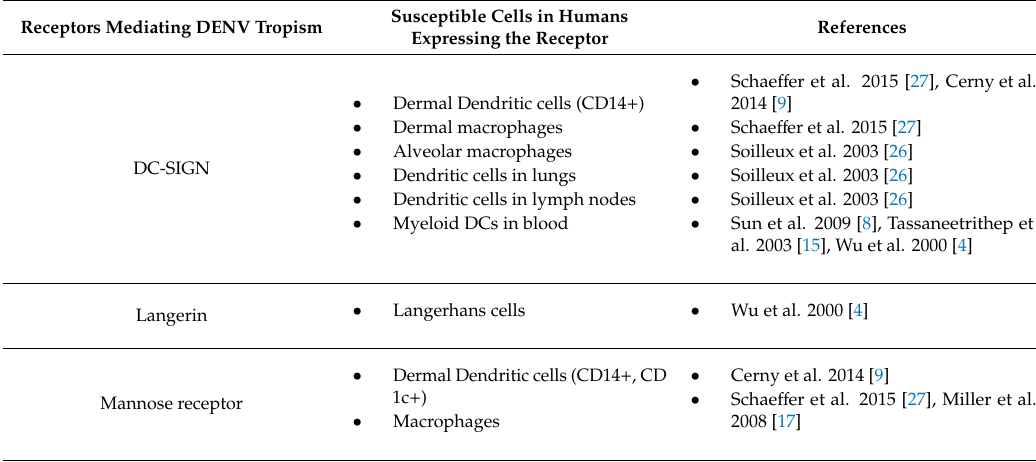
Figure 2. Multiple receptors used by DENV for entry in the host. PS / PE: phosphatidylserine and phosphatidylethanolamine on DENV membrane. prM: precursor membrane of DENV. E: Envelope protein of DENV. ?: Mechanism not well known. Table 1. Outline of the various receptors that have been studied in the context of DENV entry in susceptible immune cells.